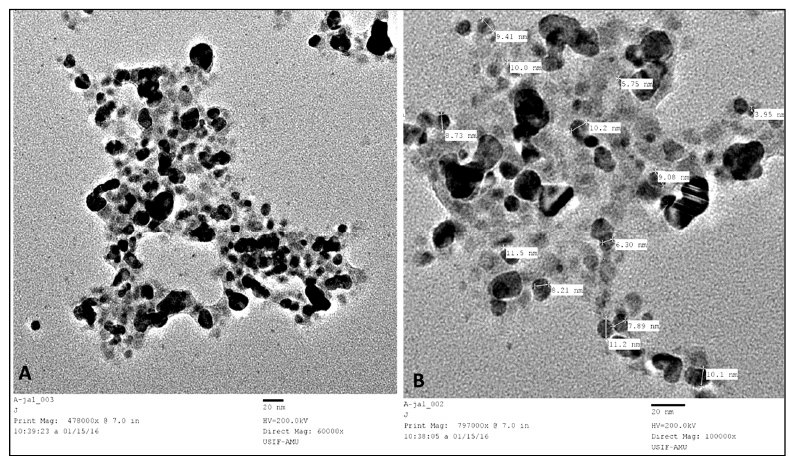
Figure 4. TEM images of AgNPs synthesized by C. glabrata supernatant. ( A ): At lower magnification (60,000×); ( B ): at higher magnification (100,000×). Antimicrobial activity of biosynthesized AgNPs against human pathogenic microorganisms, i.e., Candidal spp. and bacterial spp. was evaluated by agar well diffusion and two-fold microdilution methods. A zone of inhibition test of mycosynthesized AgNPs against tested bacteria and Candida spp. at different concentrations are shown in Figures 5 and 6, and it was very clear that AgNPs had an excellent inhibition zone against all strains. The inhibition zone diameter showed that AgNPs were more effective against bacterial strains in comparison to fungi (Figures 5 and 6). No antimicrobial activity has been observed by the C. glabrata supernatant. Further, the antimicrobial properties of AgNPs against various bacterial and fungal strains were examined by determining the